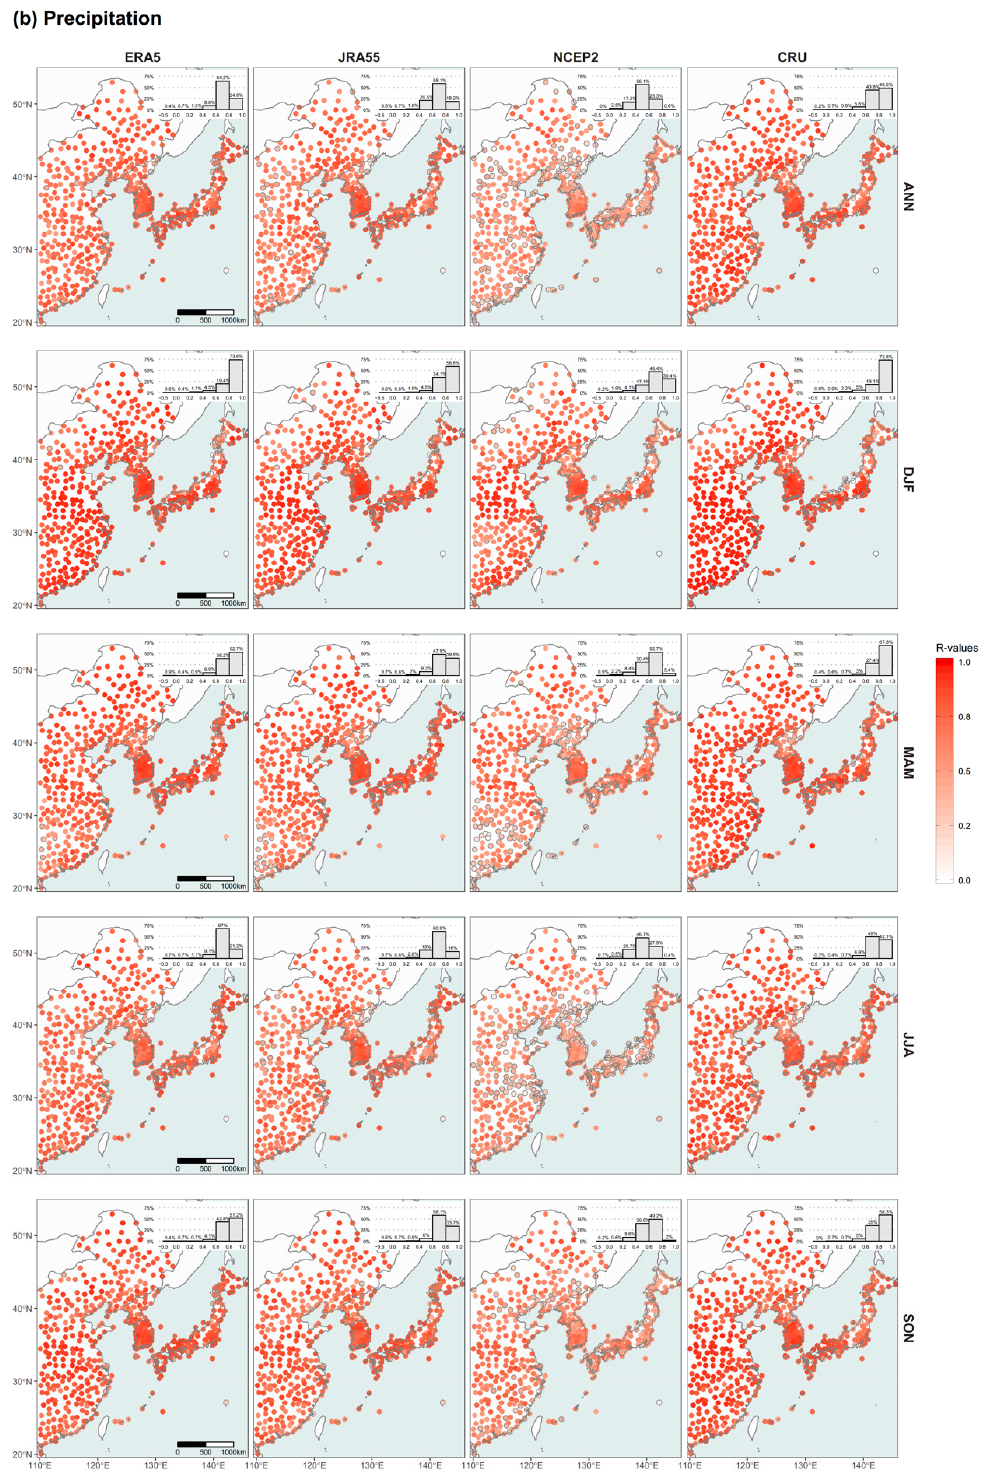
Figure 4. Pearson (R) correlation coefficients of ( a ) temperature and ( b ) precipitation from ERA5, JRA55, NCEP2, and CRU with observations in the EAM region for annual and seasonal means during the forty years of 1981–2020 for North Korea, South Korea, and Japan and the thirty years of 1981–2010 for China. Gray edges around points represent insignificant correlation ( p -value > 0.01). Histograms at the upper-right corner of map show that the numbers of stations belonging to each range of correlation